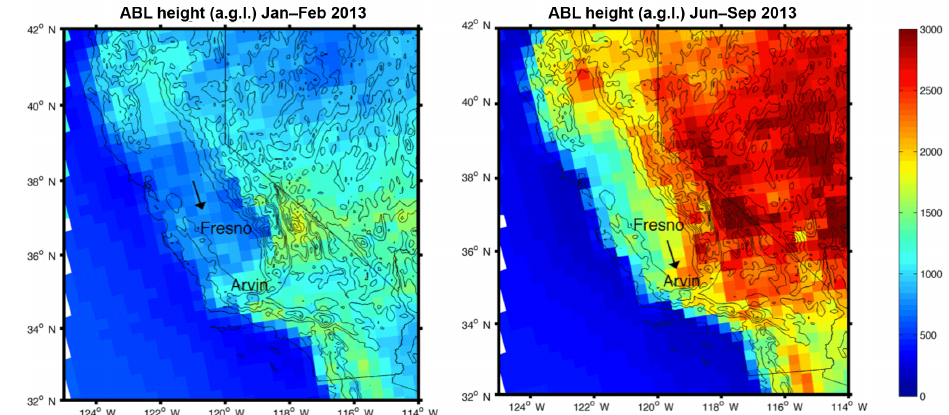
Figure 3. The average spatial pattern of boundary-layer heights from the NCEP NARR data set for (left) the winter period, and (right) the summer period of this study. Wind vectors represent the mean in situ winds measured by the aircraft near the ABL